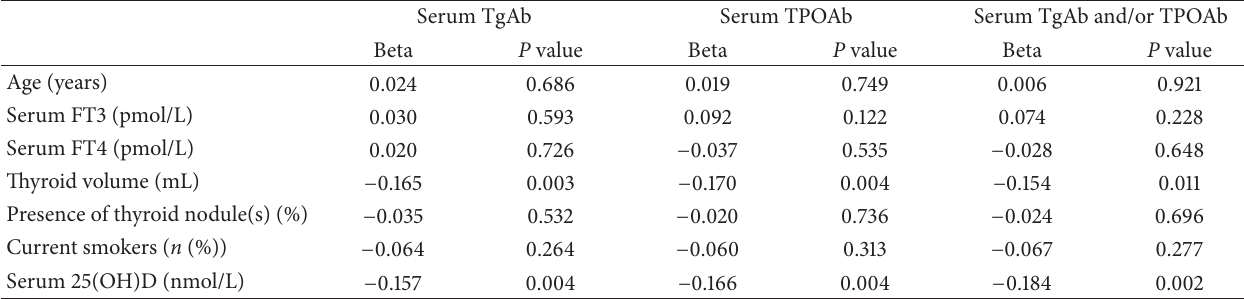
Table 5: Standardized regression coefficients of variables in relation to serum TSH in males with negative serum